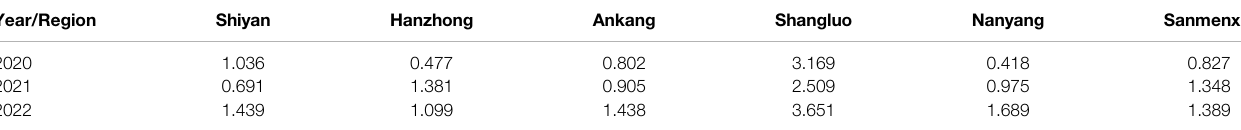
TABLE 6 | Amount of ecological compensation for regions in water source areas in 2020 – 2022. Unit: 10 9 yuan.